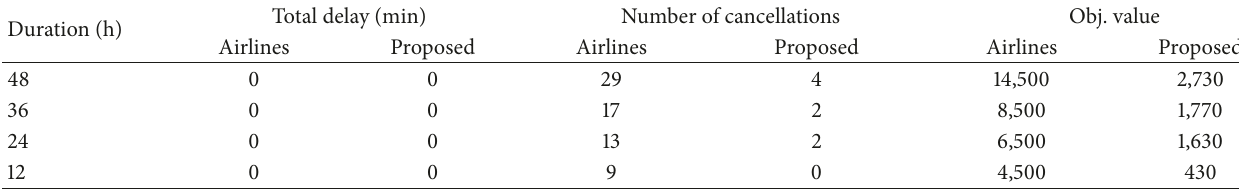
Table 7: Recovery solutions of airlines and the two-stage heuristic under different maintenance